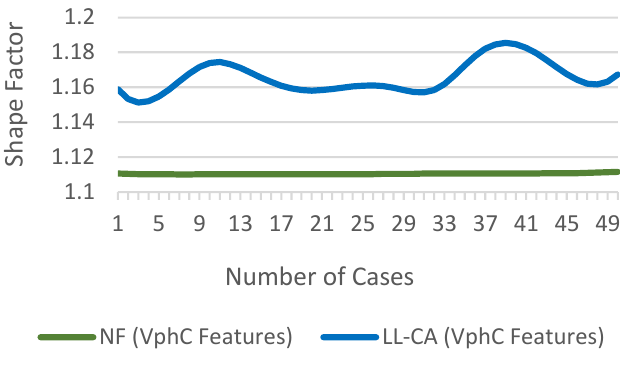
Figure 15. SF of Vph C for NF and fault